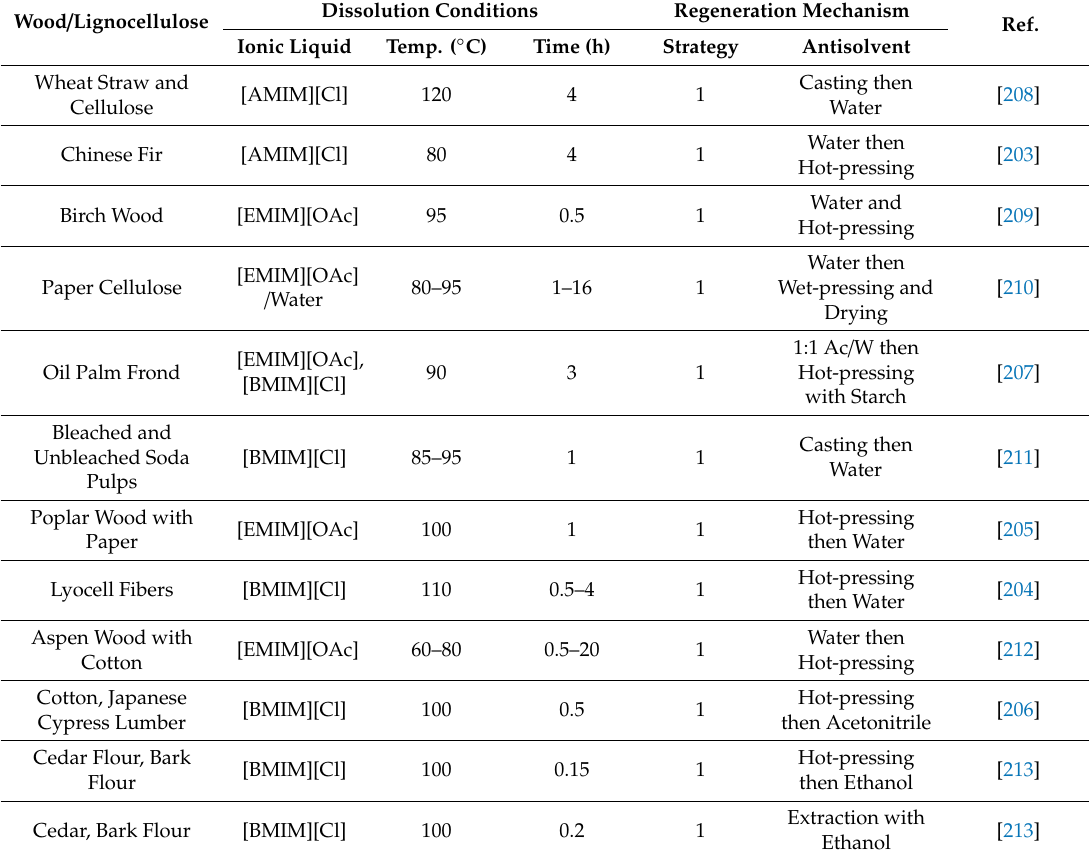
Table 4. Summary of the literature on processing all-wood and all-cellulose composites using ionic